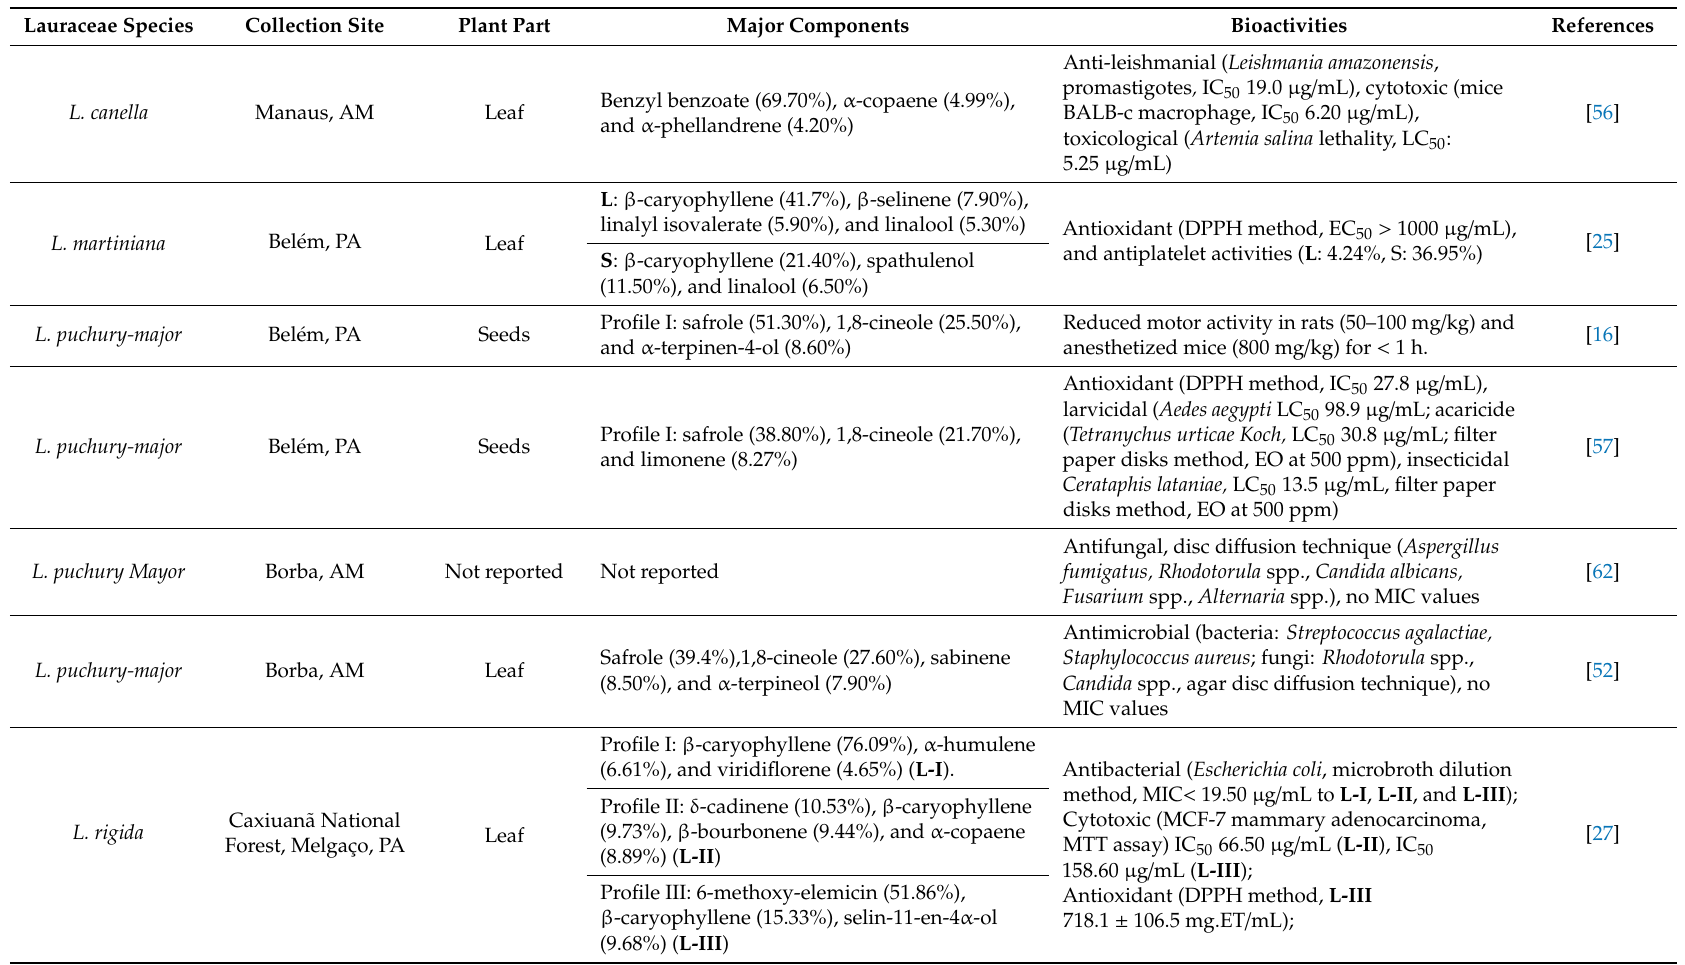
Table 2. Essential oil compositions and biological activities of essential oils from Ocotea, Nectandra and Licaria species from